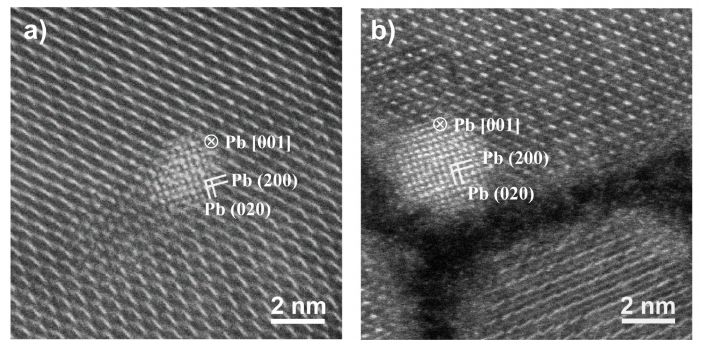
Figure 3. High-resolution STEM-HAADF images of the Pb NPs on the CsPbBr 3 NCs with [001] orientation (Pb, cubic phase,